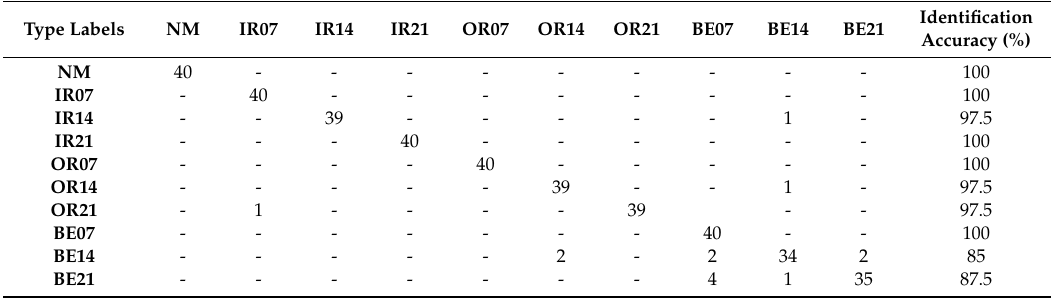
Table 4. Identification rate of the proposed rolling bearing fault diagnosis method for di ff erent fault